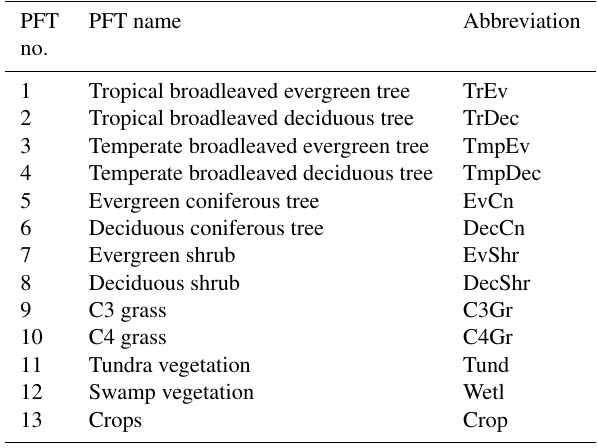
Table 1. PFTs defined in BETHY and their